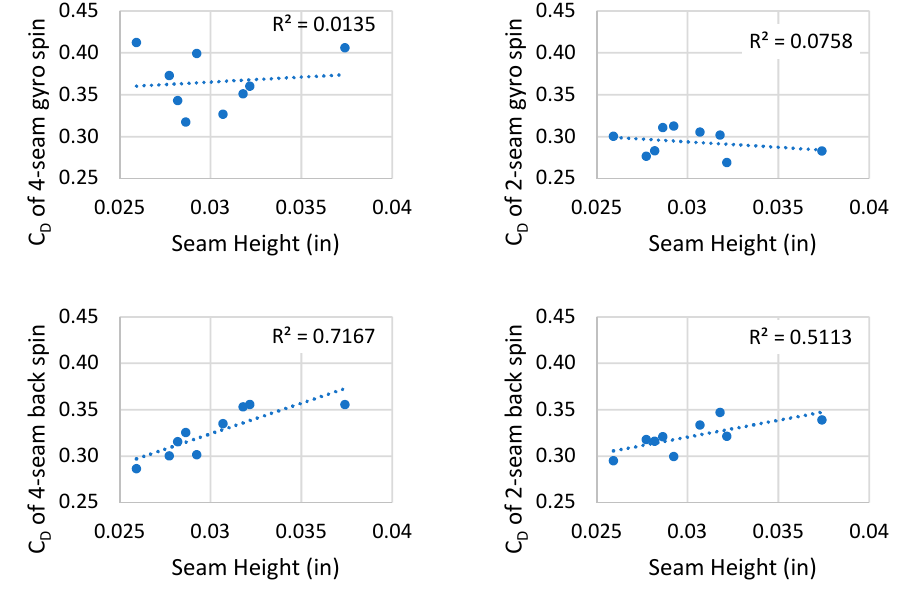
Figure 6. Drag coefficient of baseballs with different spin orientations as a function of seam height. Each data point indicates one baseball.